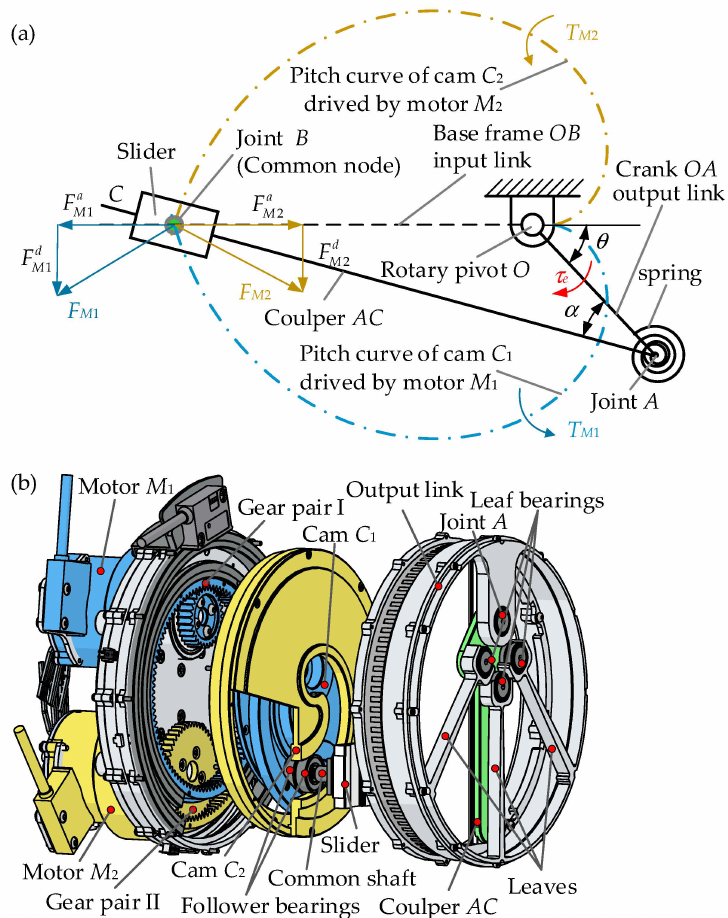
Figure 2. The proposed VSA design ( a ) Working principle; ( b ) Exploded view of the CAD model. The exploded view of the CAD model is shown in Figure 2b. The differential cams consist of two independent kinematic chains (colored by blue and yellow,